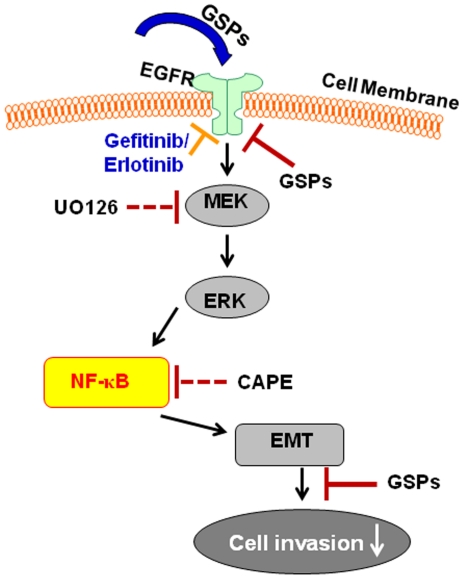
Summary of the action of GSPs on the prevention of HNSCC cell invasion.GSPs inhibit the expression levels of EGFR in human HNSCC cells, which plays a critical role in inactivation of ERK1/2, NF-κB and reversal of epithelial-to-mesenchymal transition. Collectively, these effects lead to GSPs-induced inhibition of cancer cell invasion. However, all these effects of GSPs may not be solely caused by the inhibition of EGFR expression; other targets may also play a role and that need to be further identified.